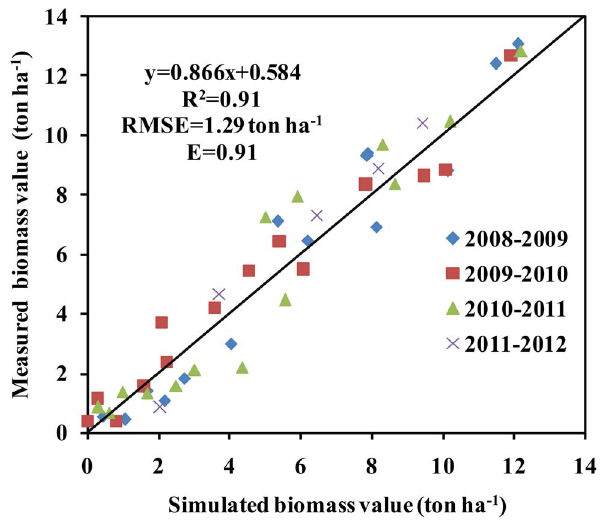
Figure 5. Relationship between the measured and simulated biomass yield (BY) in winter wheat across 4 years. Note: x represents the simulated BY, y represents the measured BY. The intercept represents the relative error between the simulated biomass yield and the measured BY. The slope represents the consistency between the simulated BY and the measured BY.